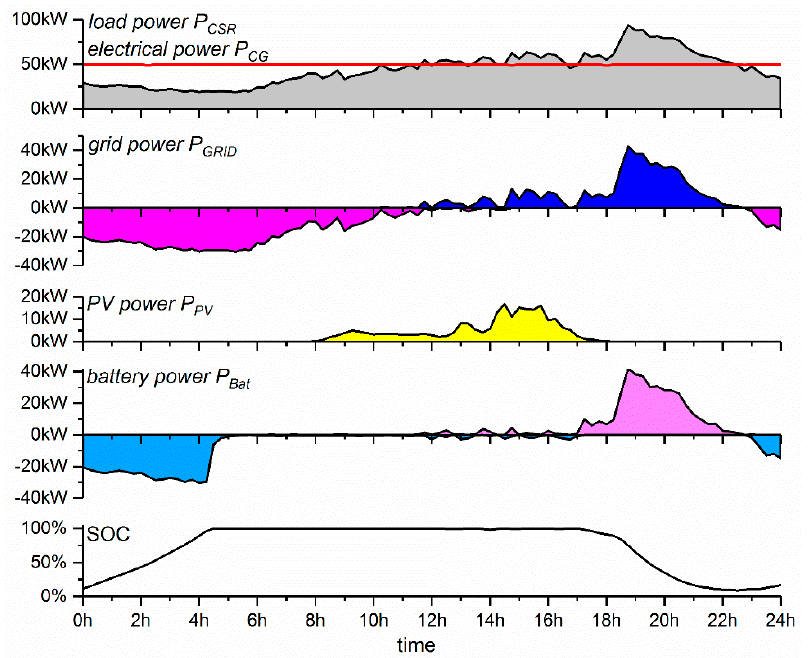
Figure 17. DG system quantities for a 24-h operating day.